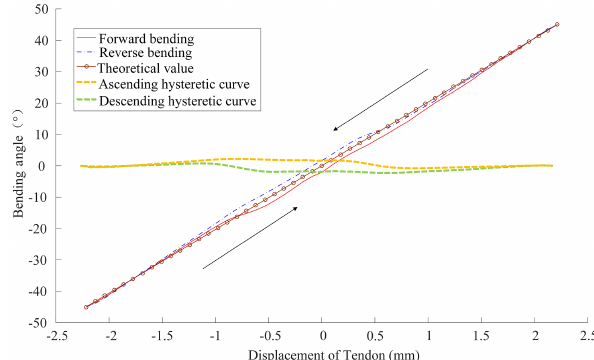
Figure 5. Hysteresis loop of the notched continuum